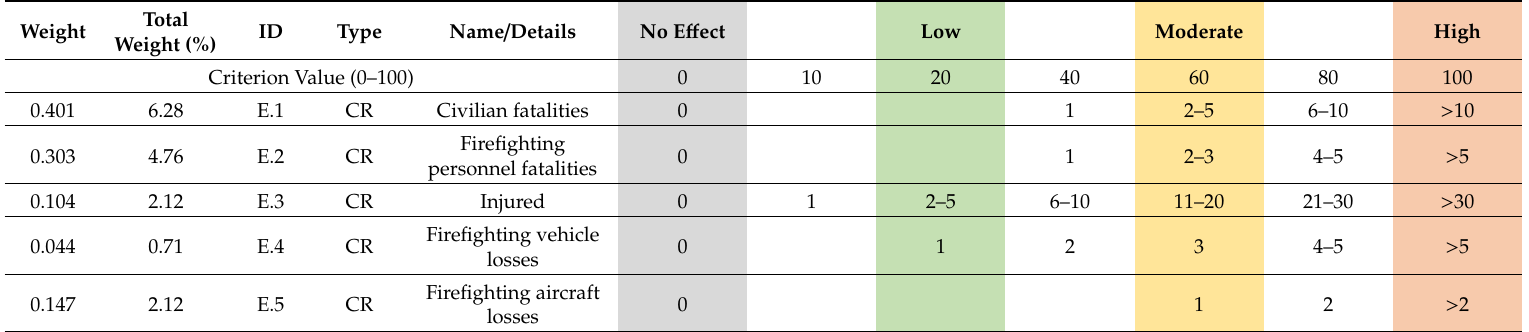
Table A5. Criteria, choices, and weights for the casualties and fatalities fire e ff ects category. CR: criterion. Light gray: Choices with no e ff ect; Dark gray: N / a, denotes a non-applicable or not available selection; Green: Choices with low e ff ect; Yellow: Choices with moderate e ff ect; Red: Choices with high e ff